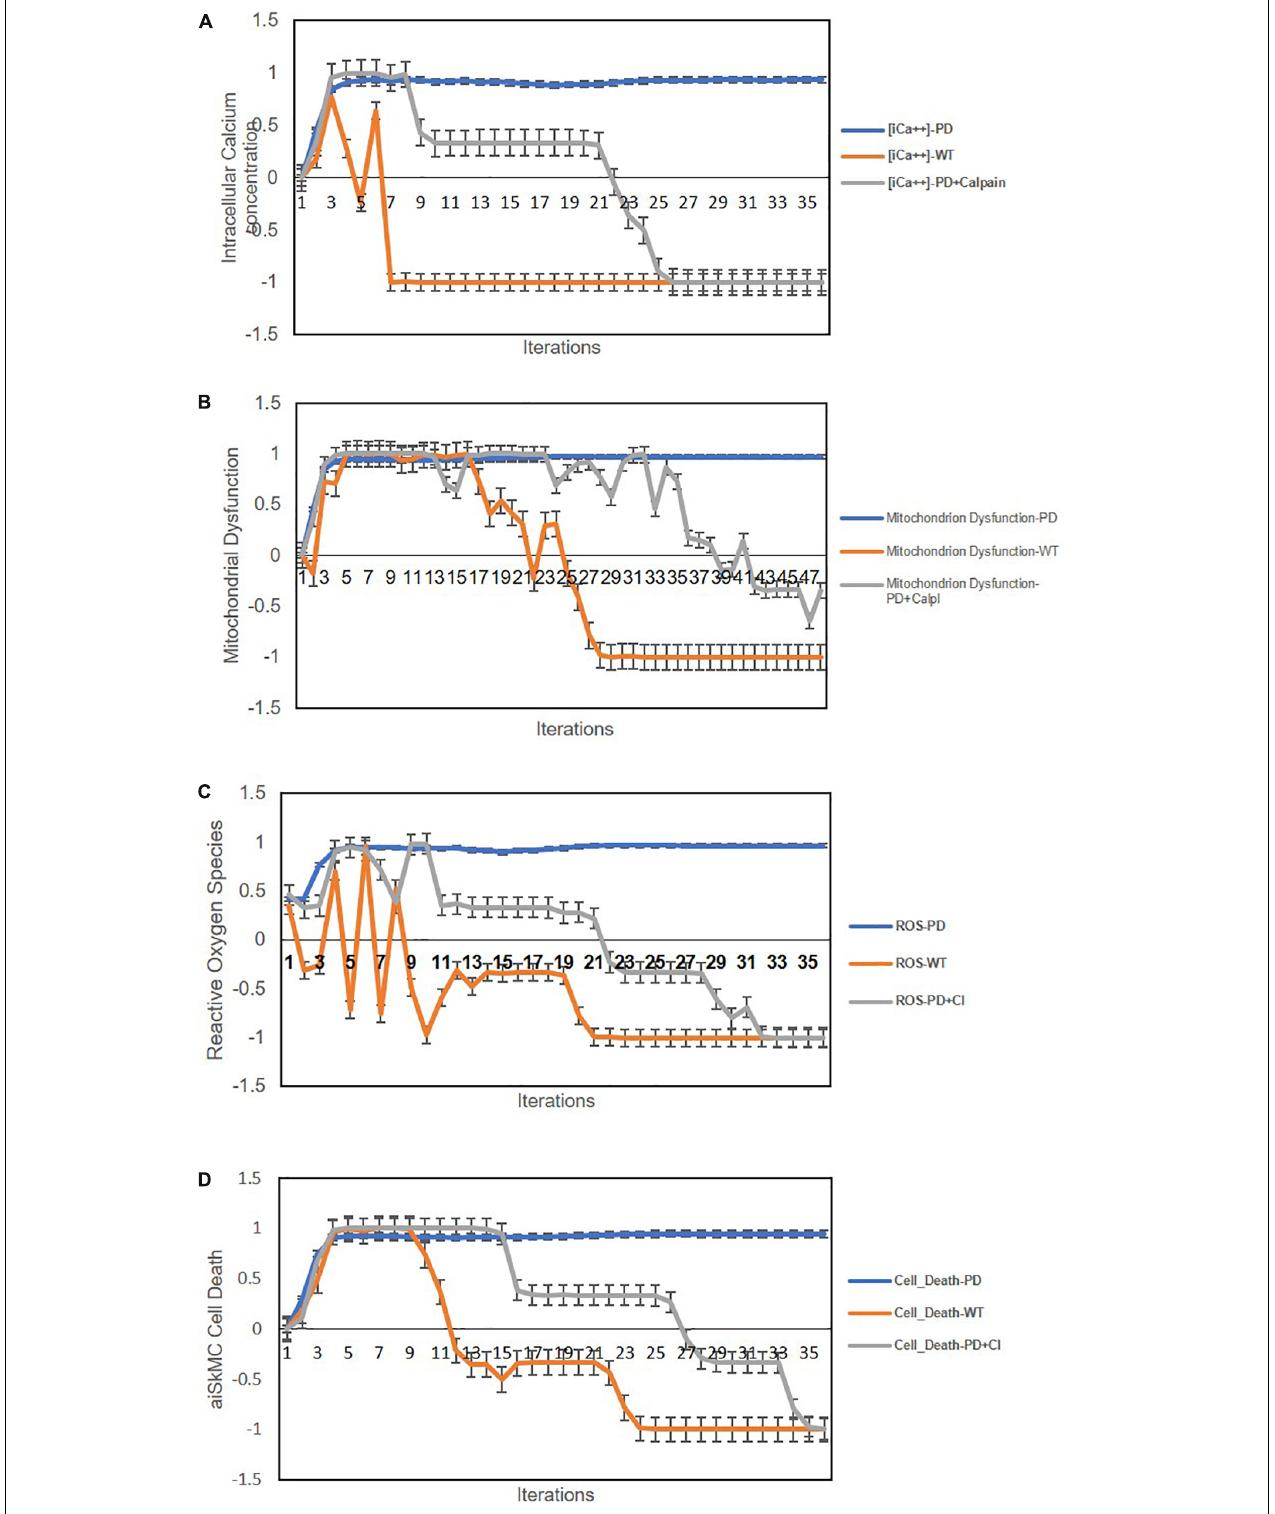
FIGURE 5 | Predicted cellular effects of limited (i.e., ≤ 20% of maximum) calpain Inhibition (IOPD vs. WT simulations). (A) Effect of calpain inhibition on intracellular calcium concentration. (B) Calpain inhibition effect on mitochondrial dysfunction. (C) Effect of calpain(s) inhibition on ROS. (D) Effect of calpain(s) inhibition on cell death. Data are representative of three independent simulation experiments; e rror bars indicate ± SEM.